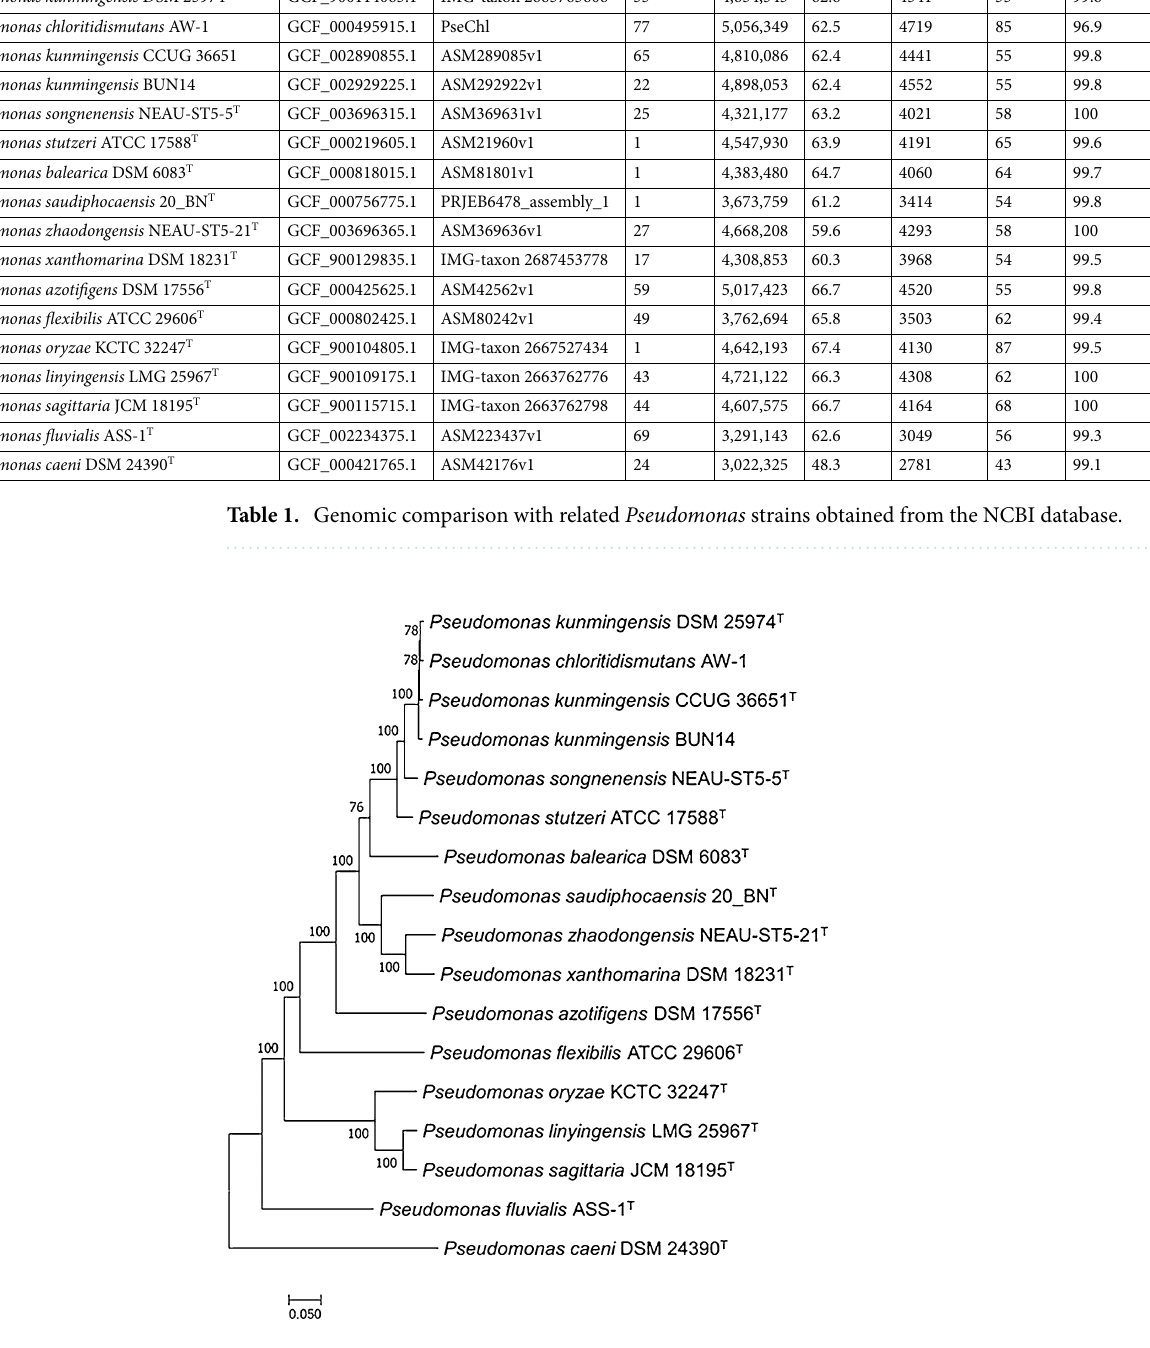
Figure 3. Phylogenomic analysis of strain BUN14 and 16 closest Pseudomonas type strains . The maximum likelihood (ML) tree was inferred from the concatenated protein alignment (376,464 amino acids) of 1238 single copy proteins. The phylogeny was generated using IQ-TREE version 1.6.7 based on the LG + F + R5 model with the bootstrap option-bb